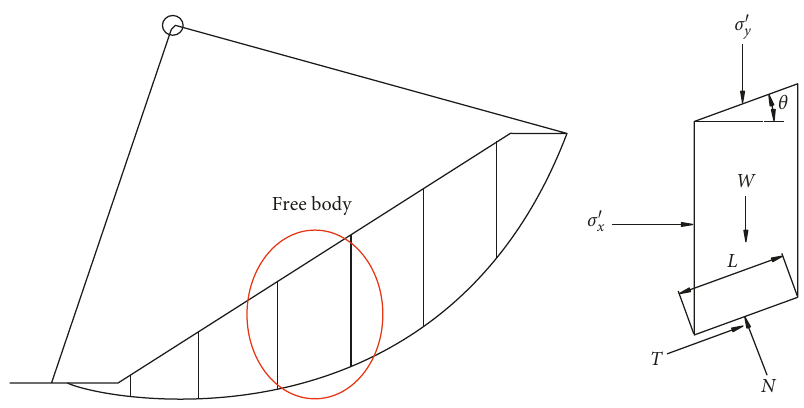
Figure 7: Stress state of a free body in the